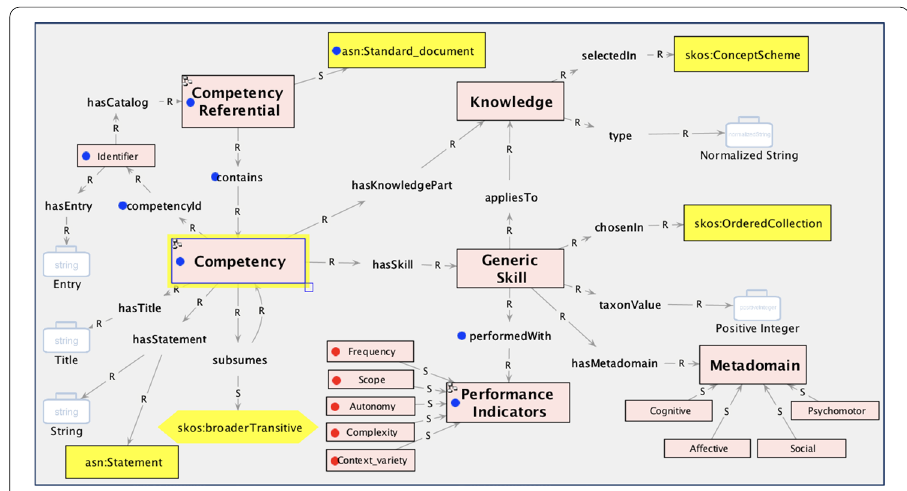
Fig. 3 The Core COMP2 competency